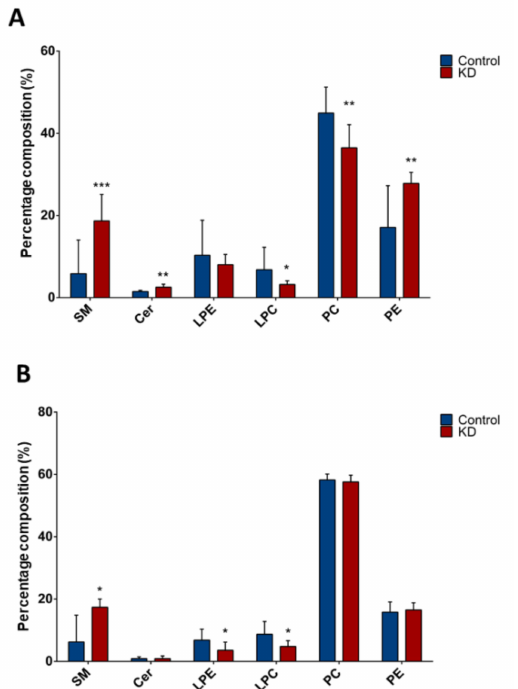
Figure 2. Composition of lipid classes in Huh-7 / HepG2 cells depleted for macroH2A1. ( A ) Percentage composition of lipid classes in macroH2A1 KD Huh-7 cells (in red) and control cells (in blue). ( B ) Percentage composition of lipid classes in macroH2A1 KD HepG2 cells (in red) and control cells (in blue). Data are represented as median and interquartile range (IQR); * p < 0.05; ** p < 0.01; *** p < 0.001 based on Mann–Whitney test. SM, sphingomyelin; Cer, ceramides, LPE, lysophosphatidylethanolamines; LPC, lysophosphatidylcholines; PC, phosphatidylcholines; PE,